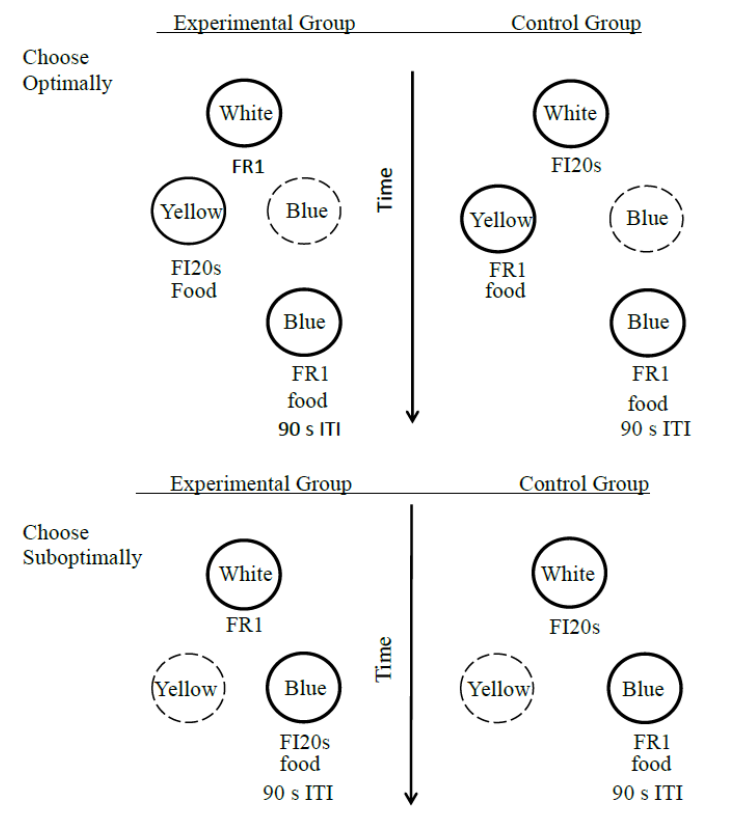
Figure 6 . Design of the Zentall et al. (2017a) experiment: Events that occurred following an optimal choice (top) and following a suboptimal choice (bottom). Prior Commitment group on the left, No Prior Commitment group on the right. Optimal and suboptimal colors (yellow and blue) were counterbalanced over pigeons, and sides (left and right) were counterbalanced over trials. 90-s intertrial interval (ITI) separated the